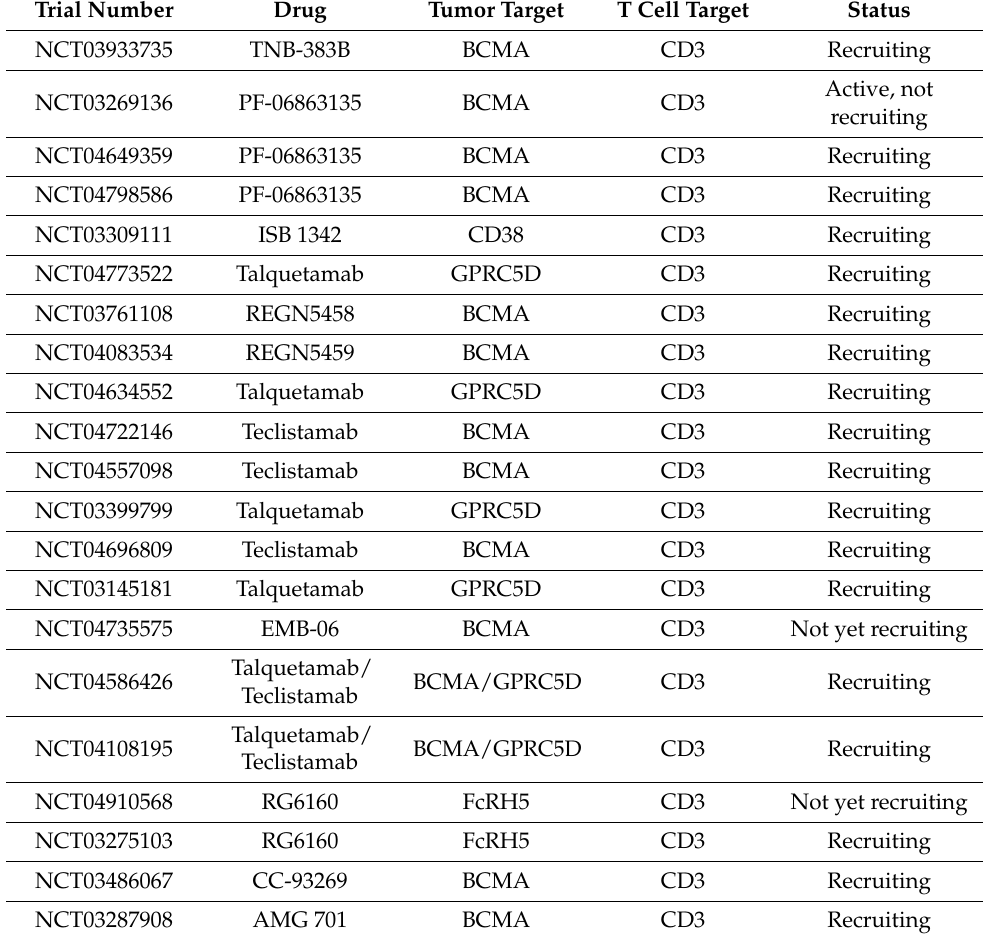
Table 1. Current clinical trials examining the use of bi-specific antibodies in multiple